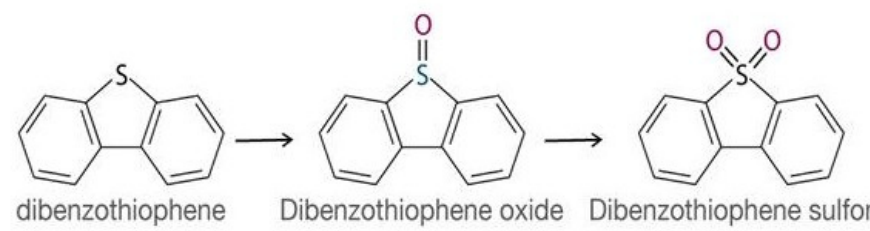
Figure 2. DBT sulfone formation.